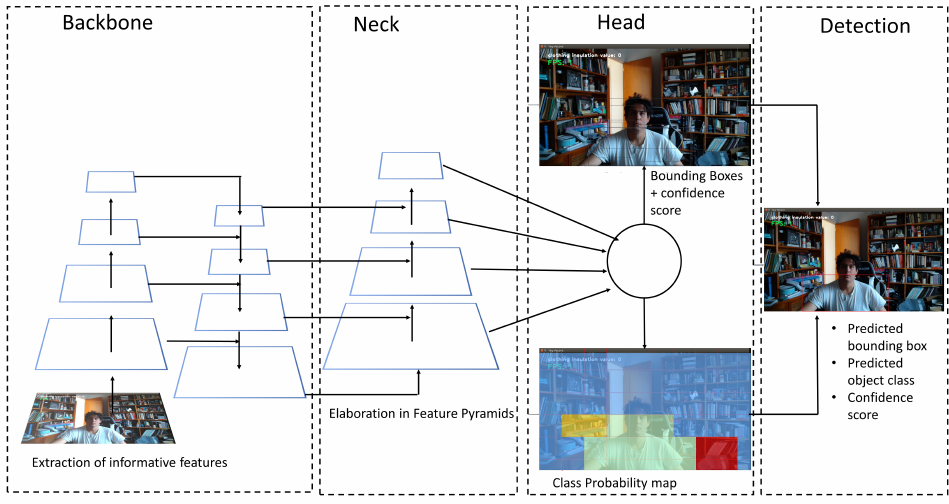
Figure 4. YOLOv5 architecture